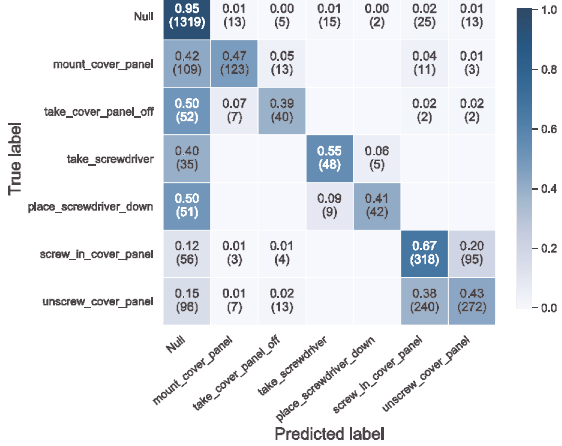
Fig. 5. Confusion matrix of C-DRNN on the OCA dataset with combined screw and unscrew cover panel. Table 6. Weighted F 1 def-score of